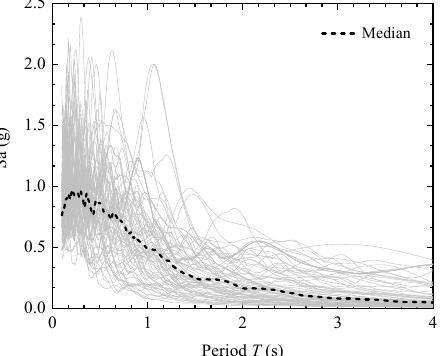
Figure 5. The acceleration spectra of ground motions (PGA = 0.45 g).